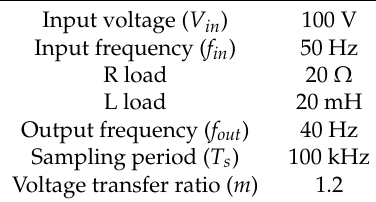
Table 6. The parameter for simulation and experimental.